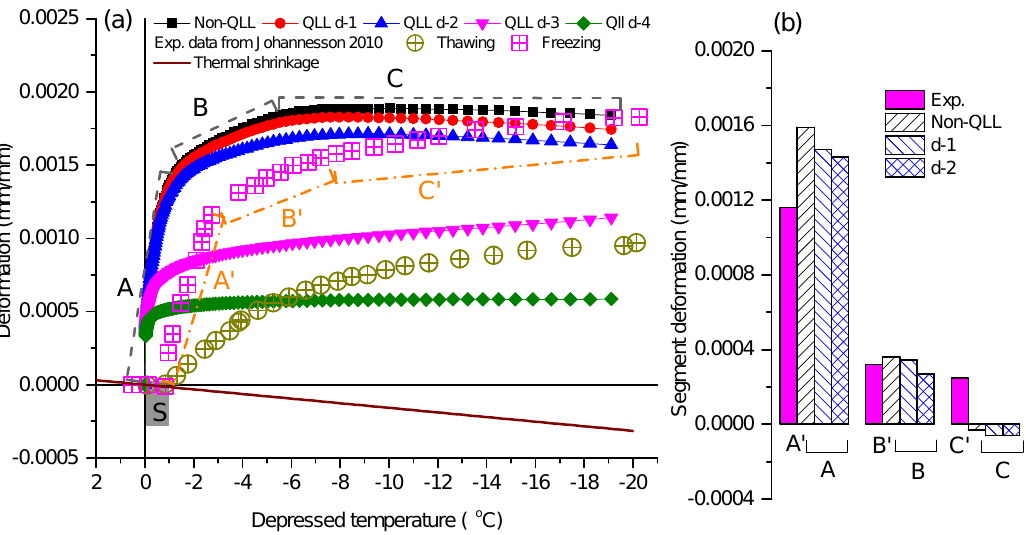
Figure 6. ( a ) Deformations of the concrete sample estimated by the poroelastic model with the different models of QLL thickness and the experimental results reported in [43]. In this figure, the experimental thawing data were corrected according to the set of (cid:101) = 0 at T = T 0 . Three segments of the modeled freezing deformations with different rising extents are marked as A, B, and C to represent the significant, moderate, and slight deformation rises by the delayed ice formation in different pores. The same freezing stages for the experiment data are marked as A’, B’, and C’, respectively. The process of supercooling monitored by the experiments is marked as S. ( b ) The comparison of the deformations at each segment between the experimental data and the predicted results in the non- and low-thickness QLL cases (d-1 and